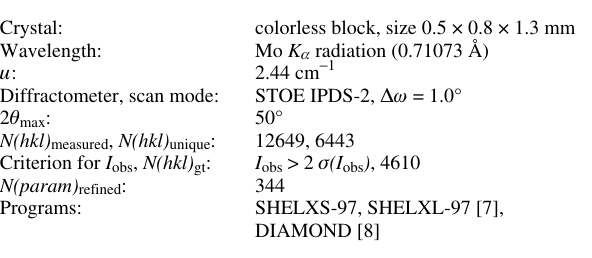
Table 1. Data collection and